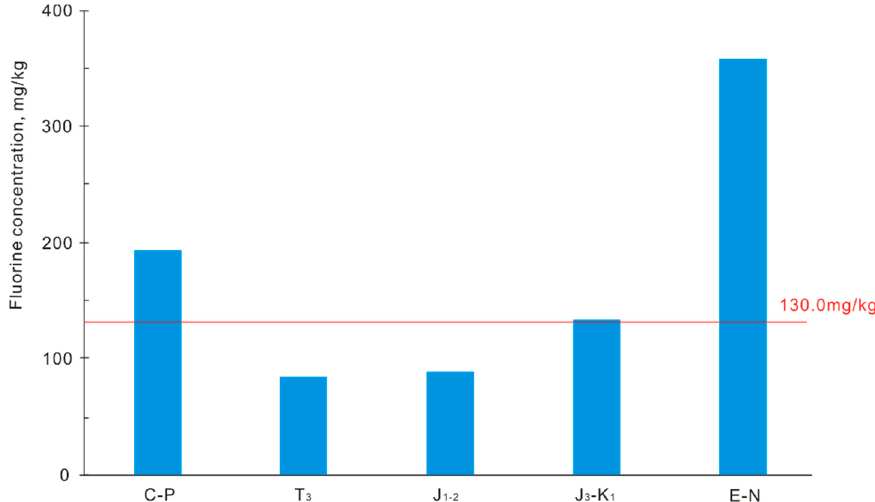
Figure 3. The fluorine content distributed in different eras of Chinese coal (1883 samples for C-P, 35 samples for T 3 , 33 samples for J 1–2 , 10 samples for J 3– K 1 , 25 samples for E-N).